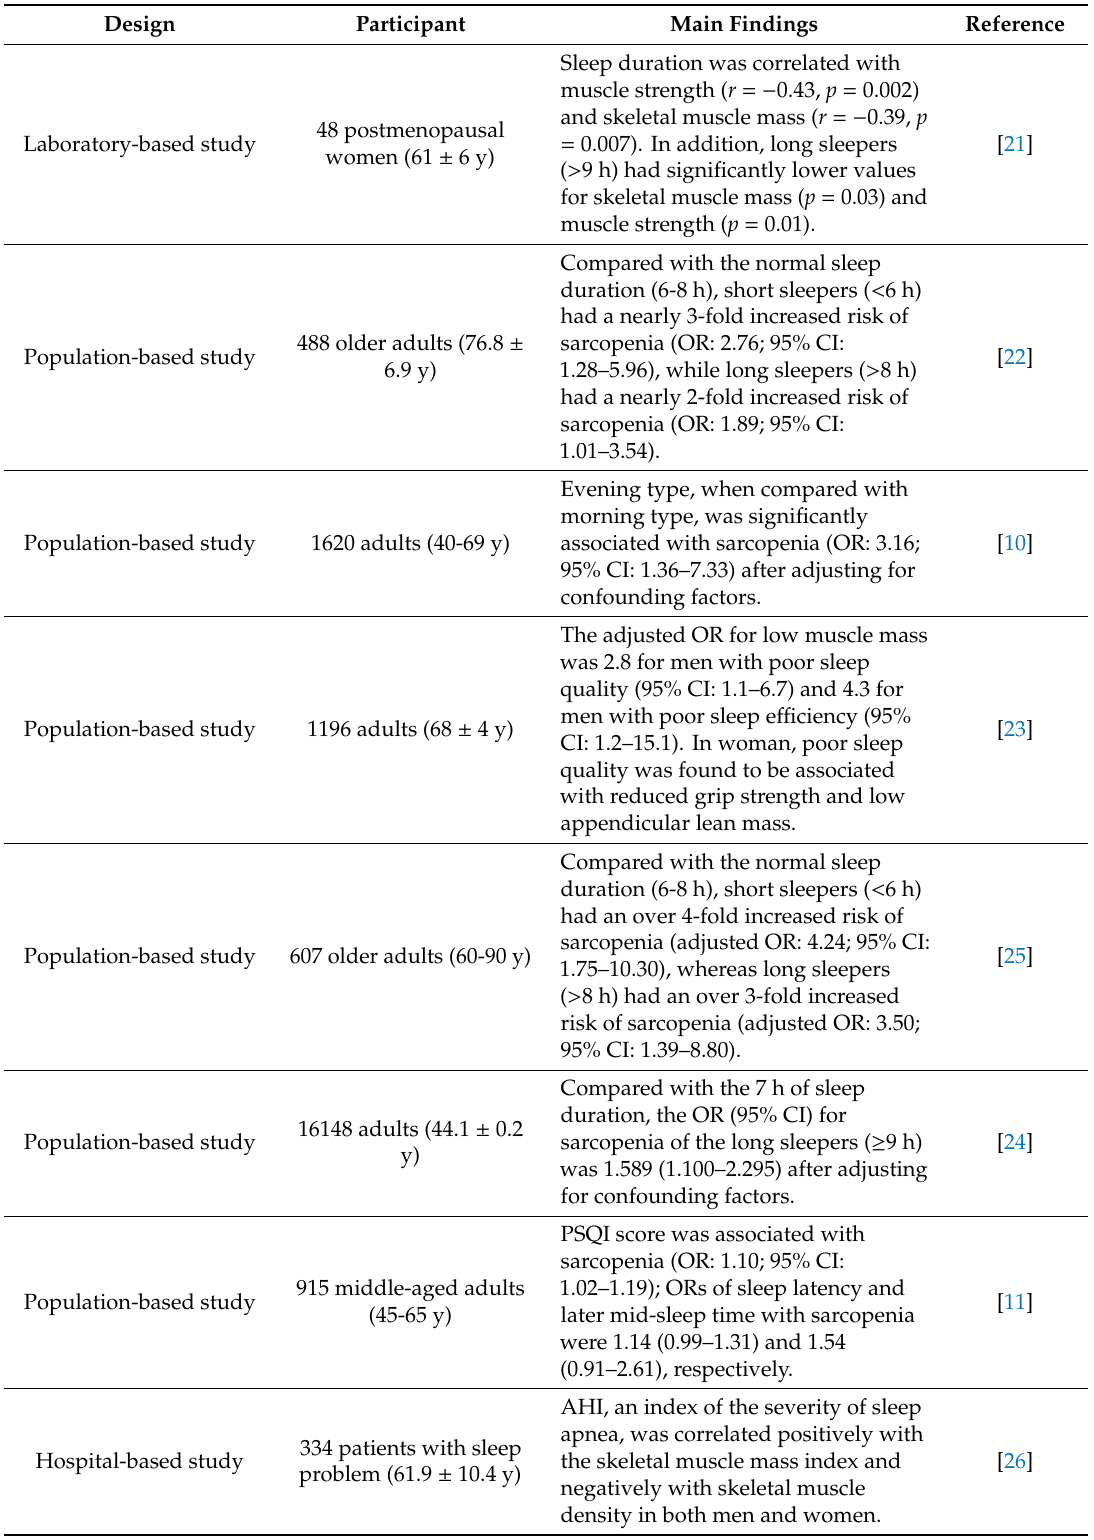
Table 1. Sarcopenia and circadian disruption in